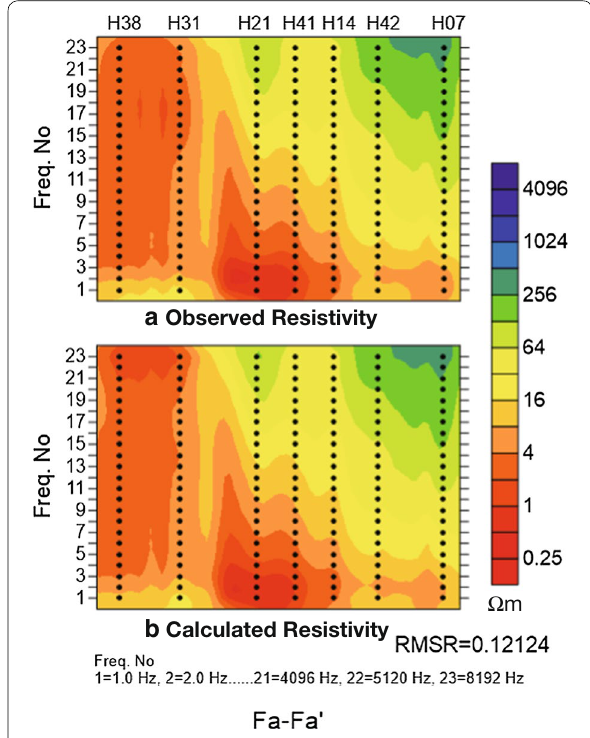
Fig. 6 Comparison of cross sections of apparent resistivity between observed ( a ) and calculated ( b ) data. The inverted resistivity is reasonably consistent with the observed, which supports the reliability of the inverted resistivity